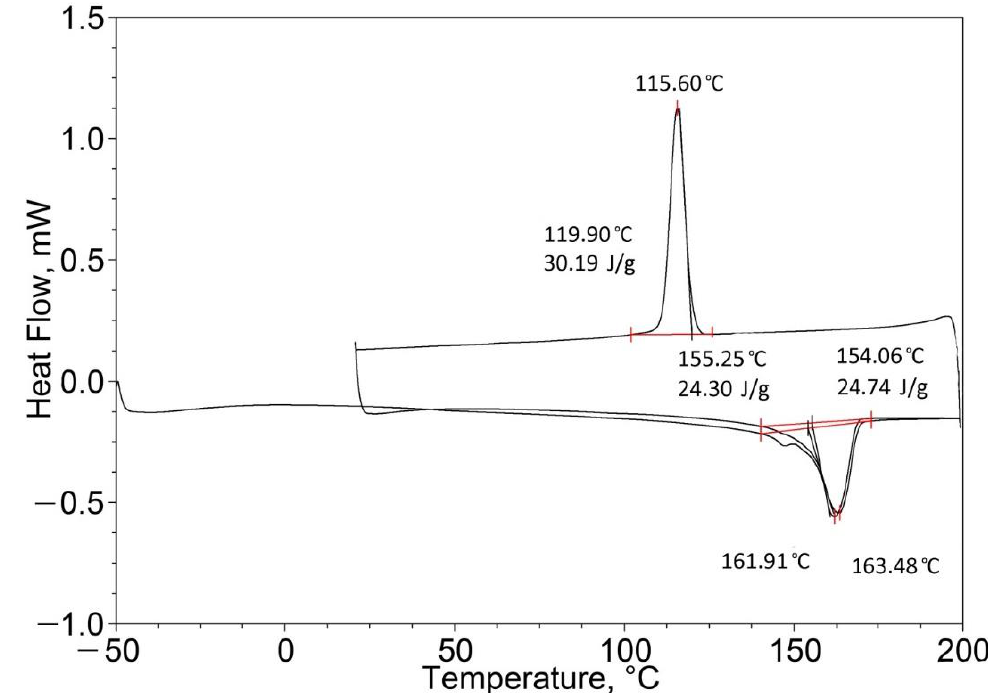
Figure 13. Melting-crystallization-melting diagram (DSC scan curves) of the 50% PP – 50% EPTSR polymer blend produced by melt blending method.